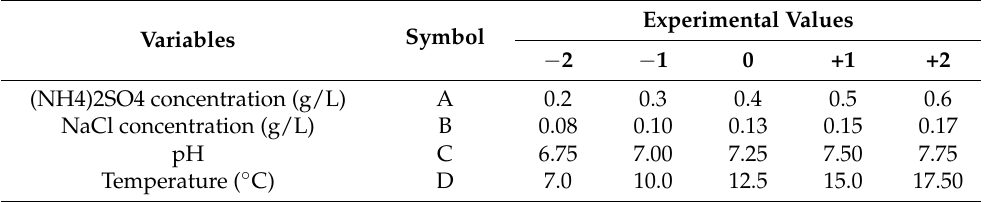
Table 1. Experimental ranges of four different variables tested in CCD.